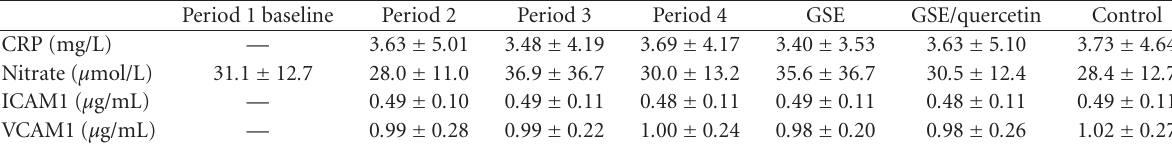
Table 4. E ff ect of GSE and GSE/quercetin on plasma CRP, nitrate/nitrite, and adhesion molecules. N = 35, mean SD.